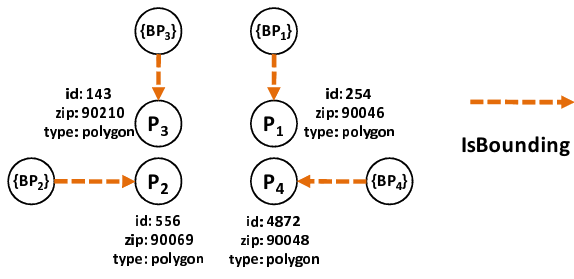
Figure 5. Boundary point and polygon node.